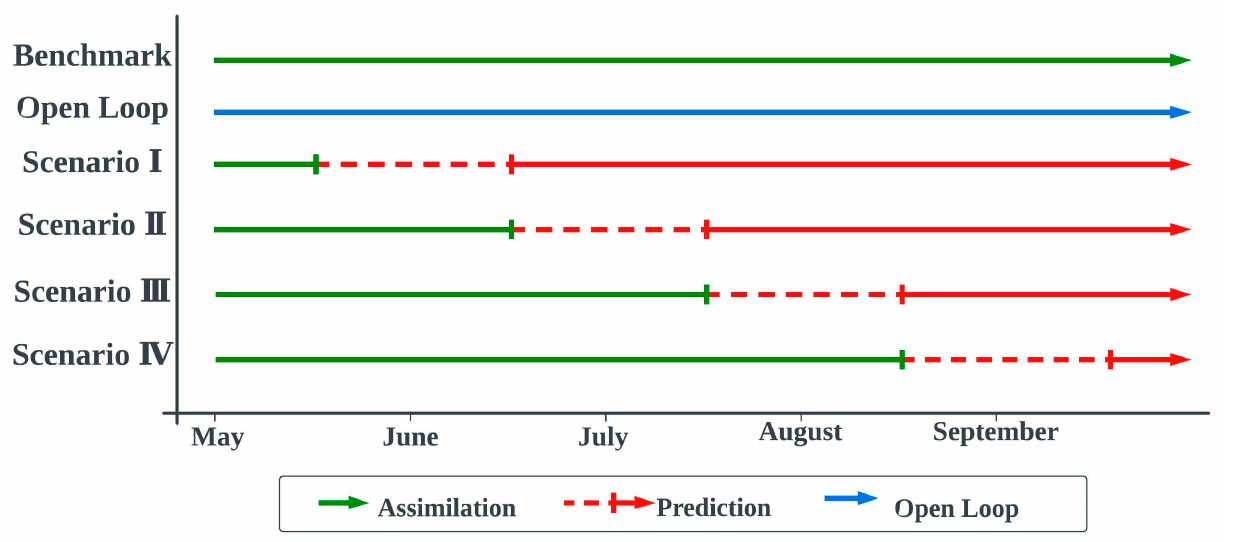
Figure 1. Diagram for four assimilation scenarios. The green arrow represents benchmarks with data assimilation; the blue arrow represents Noah-MP Open-Loop run (without data assimilation); the red arrows represent the prediction of LAI, SM, H, or LE; and the dashed lines in red arrows are the first-month prediction used for statistical analysis.